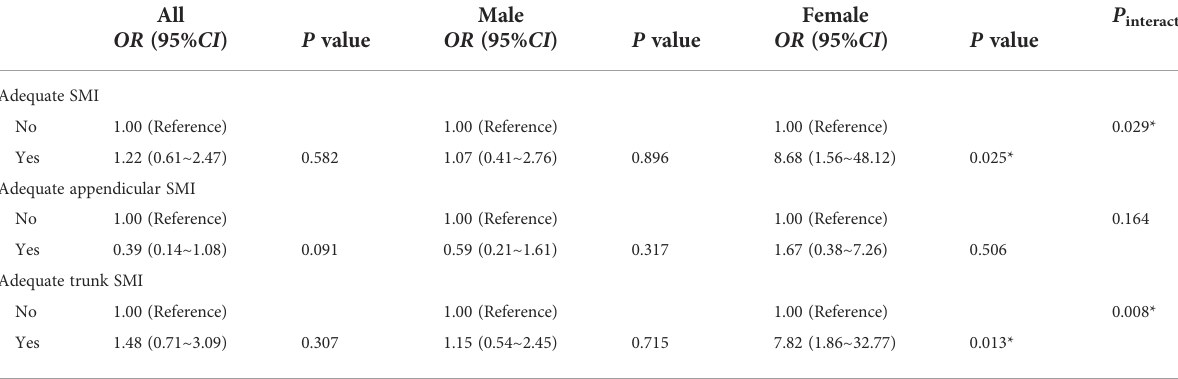
TABLE 4 Associations between adequate muscle mass status and signi fi cant fi brosis by